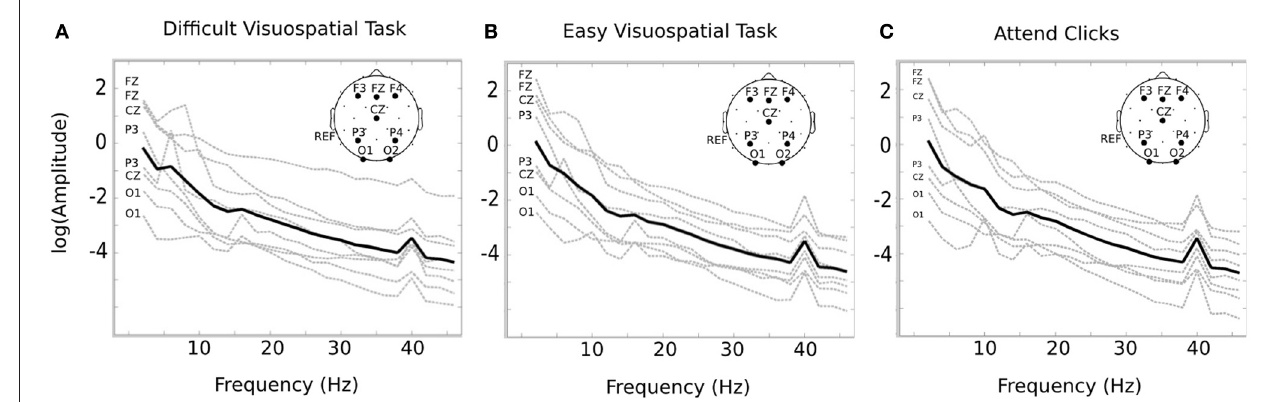
FIGURE 2 | Average SSAEP response for each condition. The spectral response is displayed for each subject for the difficult visuospatial task (A) , the easy visuospatial task (B) , and for “attend clicks” (C) . The spectral response was obtained from the channel with the largest response at 40Hz after ICA reconstruction (the channel is indicated on the left of each plot). The